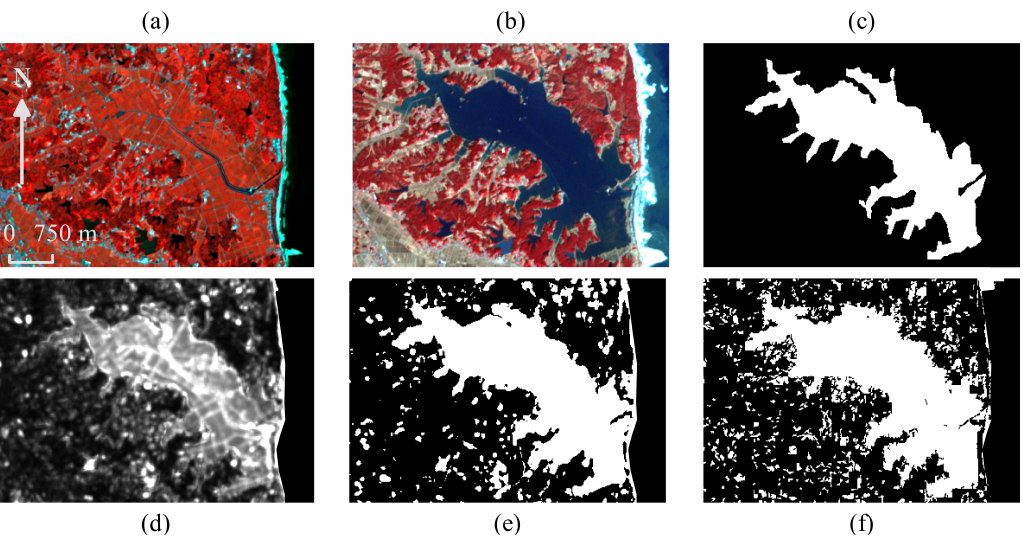
Figure 8. Change detection results. ( a ) image taken on 7 July 2010, ( b ) image taken on 19 March 2011, ( c ) ground truth, ( d ) average RE image of the proposed method, ( e ) proposed method CM, ( f )